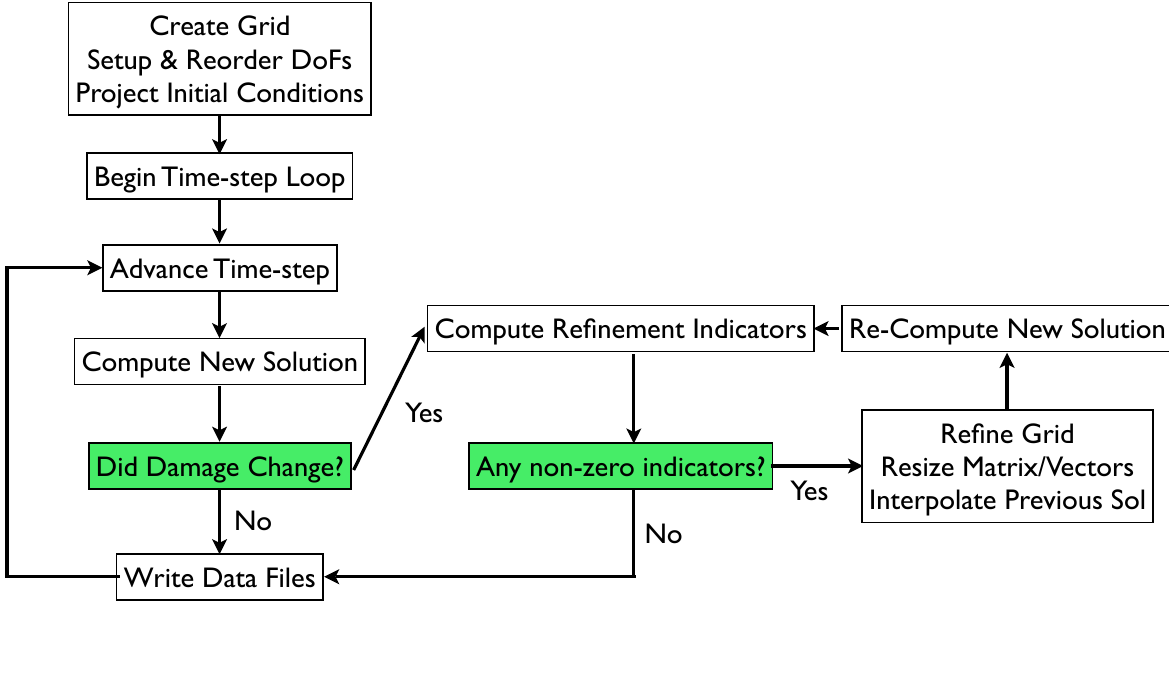
Figure 1 . Damage based refinement algorithm flow chart.